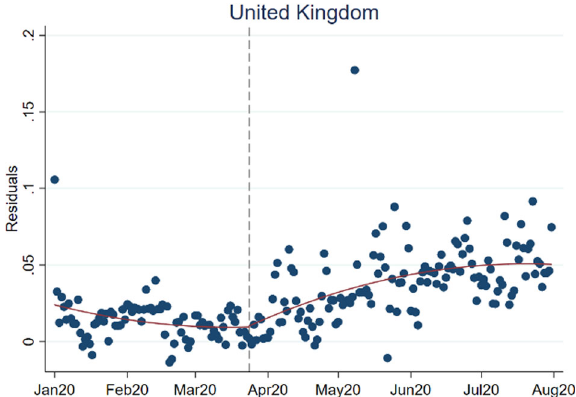
Fig. 6 Estimated coef fi cients of the change in trend at 21 break points in 2019. Note: There was no sharp change in preference around t = 0. Source: Author ’ s analysis and illustration of Spotify data.